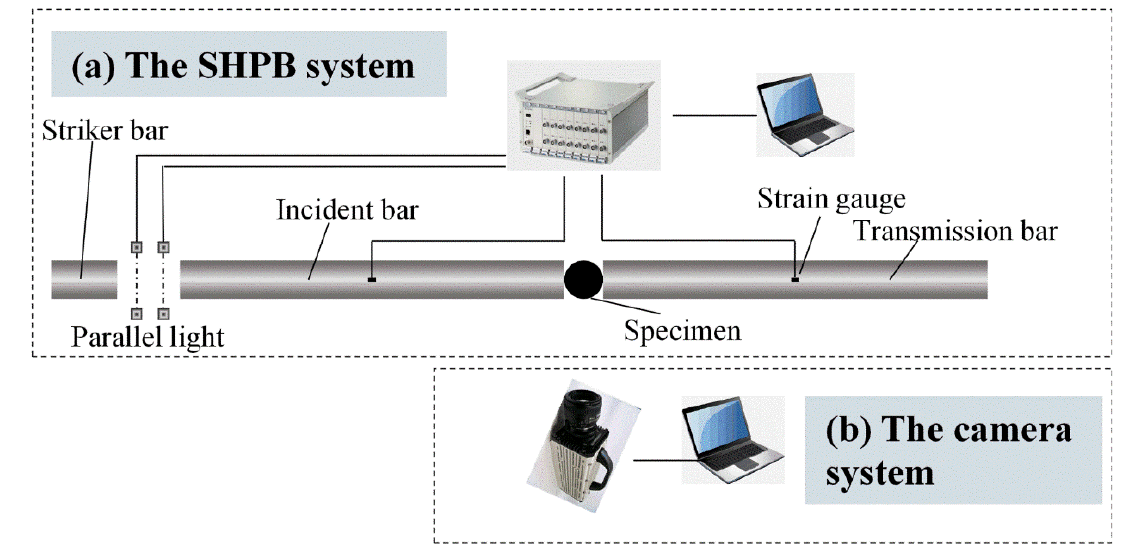
Figure 1. ( a ) the SHPB system, ( b ) the camera system.